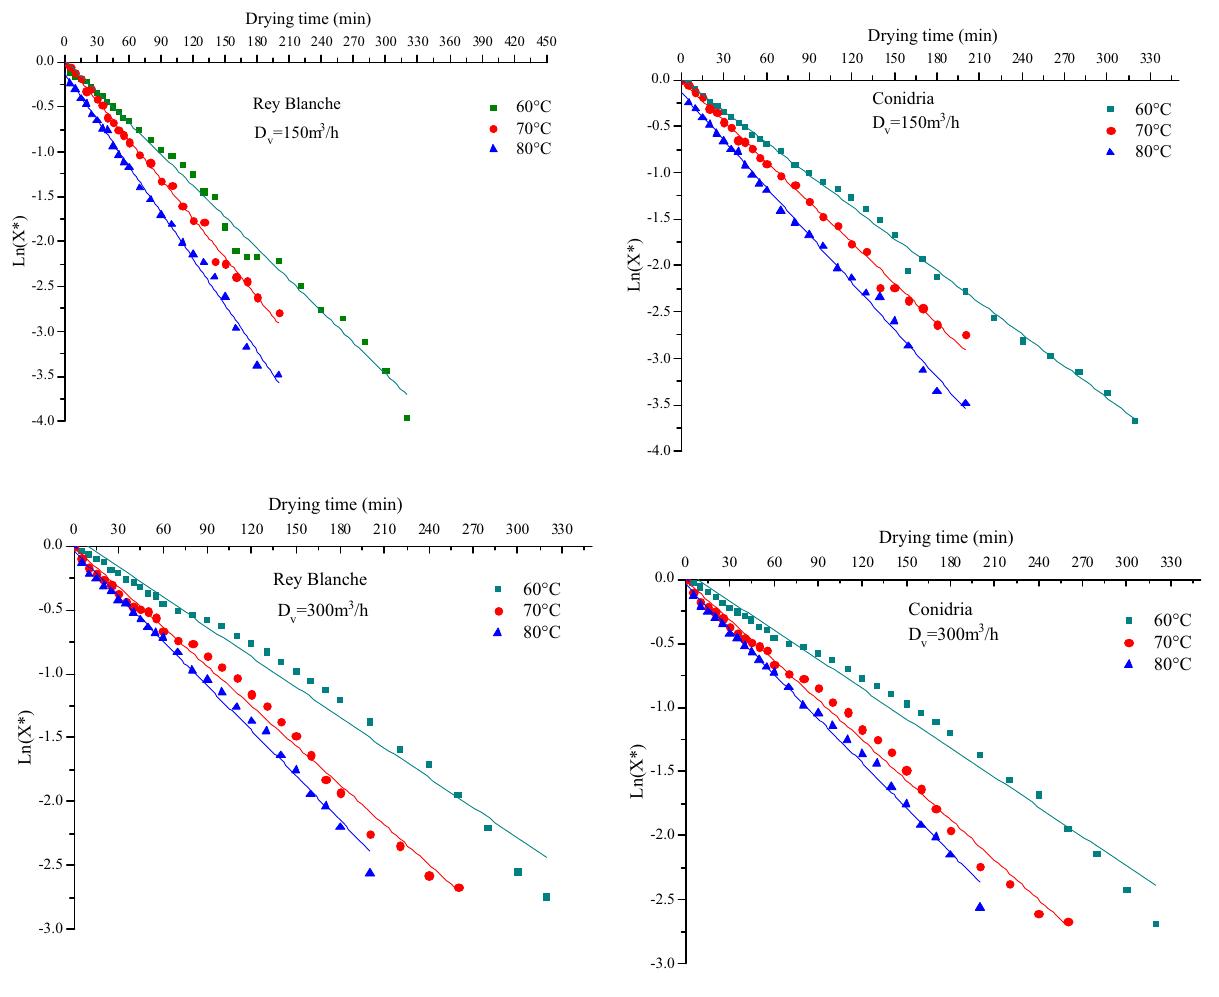
Figure 8. Plot of Ln(Y*) versus drying time in different drying air conditions for both fig varieties ‘Rey Blanche’ and ‘Conidria’.